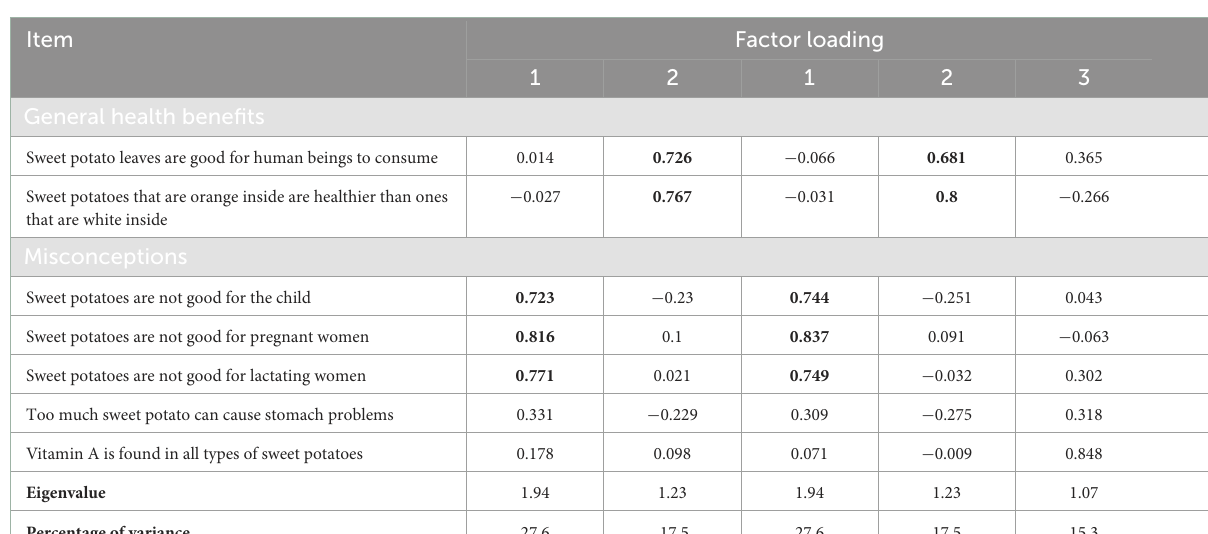
TABLE 4 Items and scale information from the exploratory analysis of knowledge about orange-fleshed sweetpotatoes included in the questionnaire.